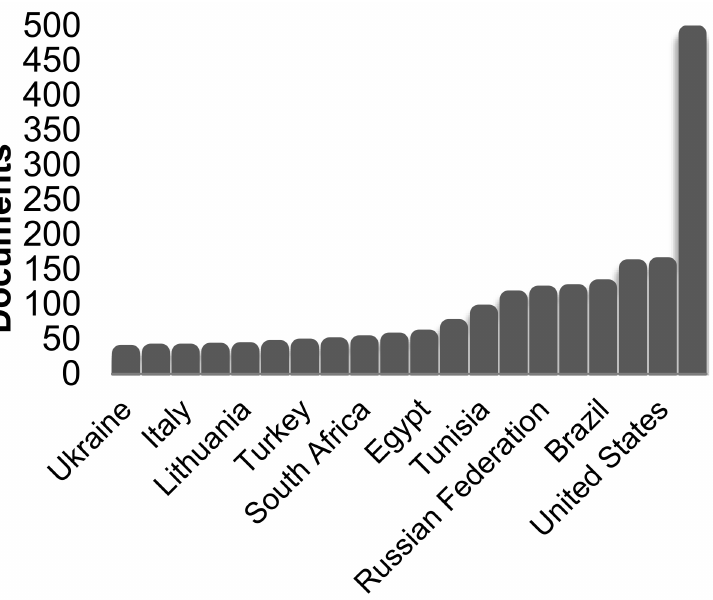
Figure 4. Comparison diagram behind the regions of research on phosphogypsum issues (Scopus